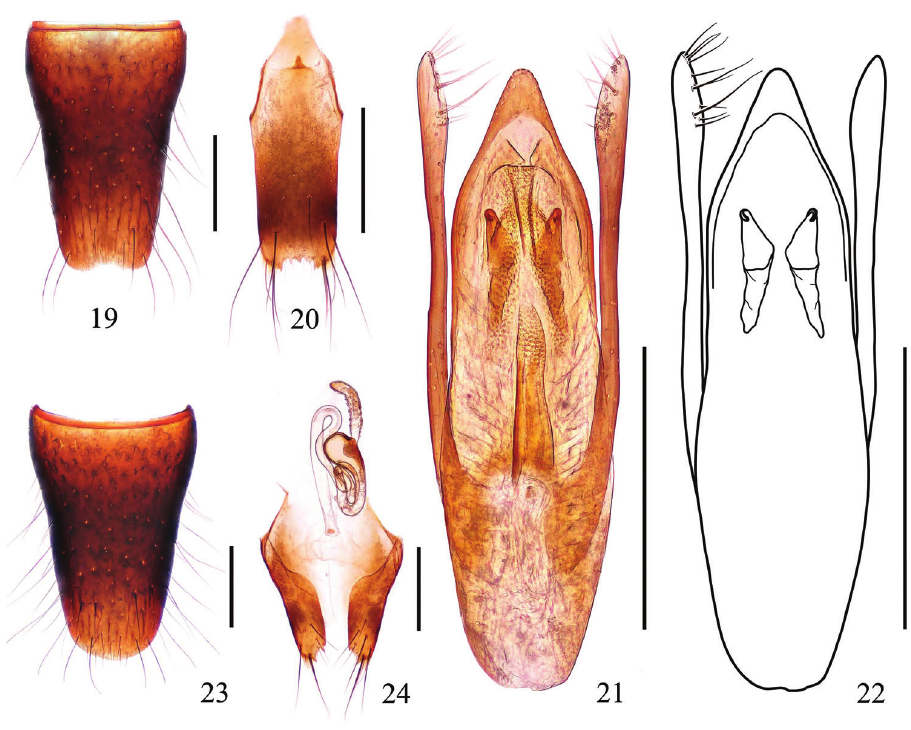
Figures 19–24. Stenus liuyixiaoi sp. n. 19 male sternite VIII 20 male sternite IX 21, 22 aedeagus 23 female sternite VIII 24 valvifers and spermatheca. Scale bars: 0.25